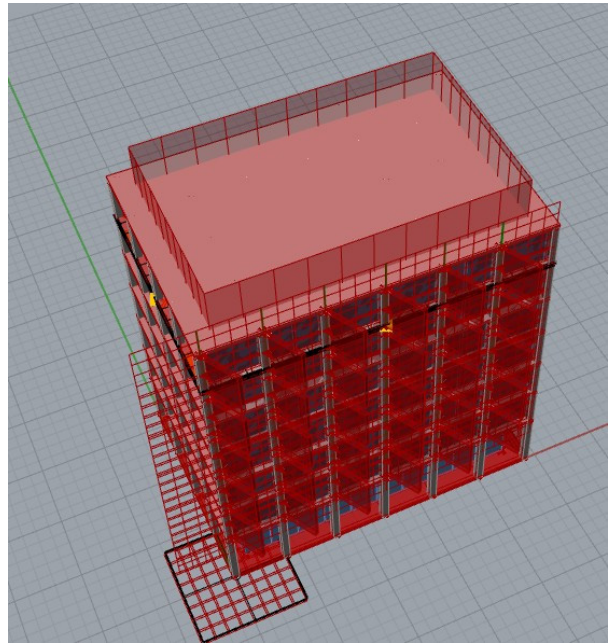
Figure 6. Model with Motion Embedded Facade Louver Panels.